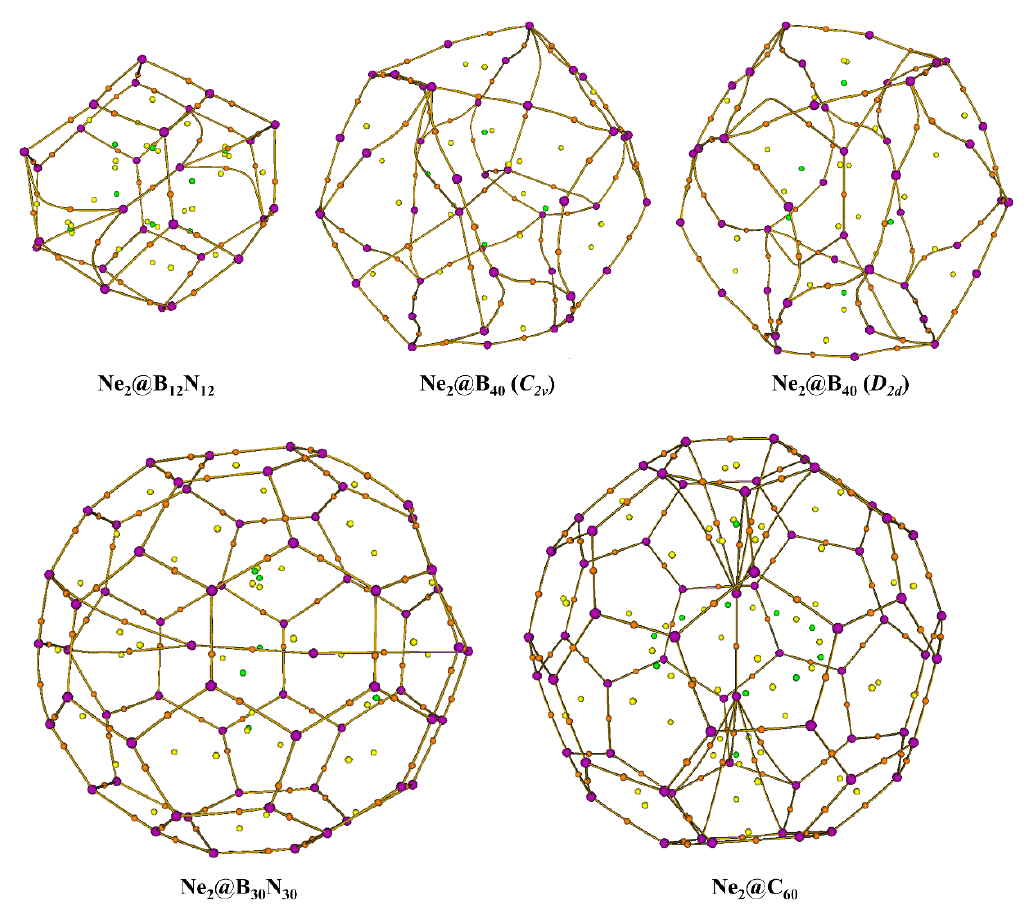
Figure 3. Molecular graphs generated for the Ne 2 @cage systems showing the bond paths. Table 4. Topological descriptors (a.u.) at the bond critical points (BCPs) between Ng atoms in Ne 2 @cage systems.